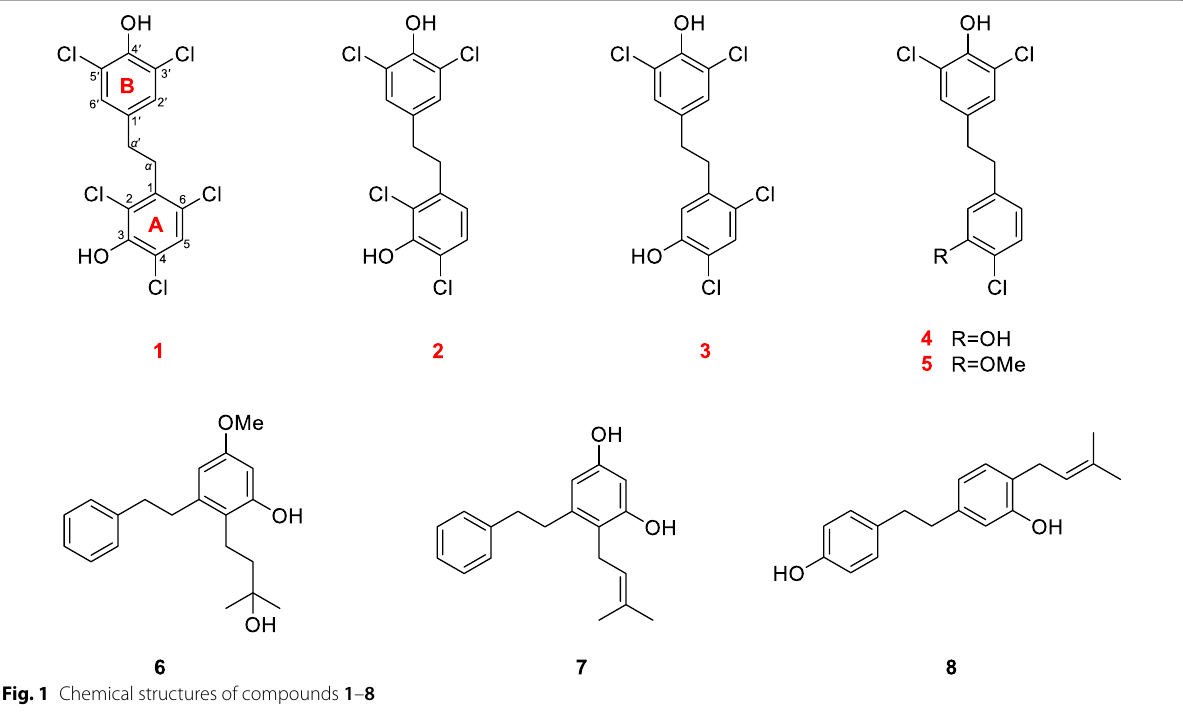
Fig. 1 Chemical structures of compounds 1 –